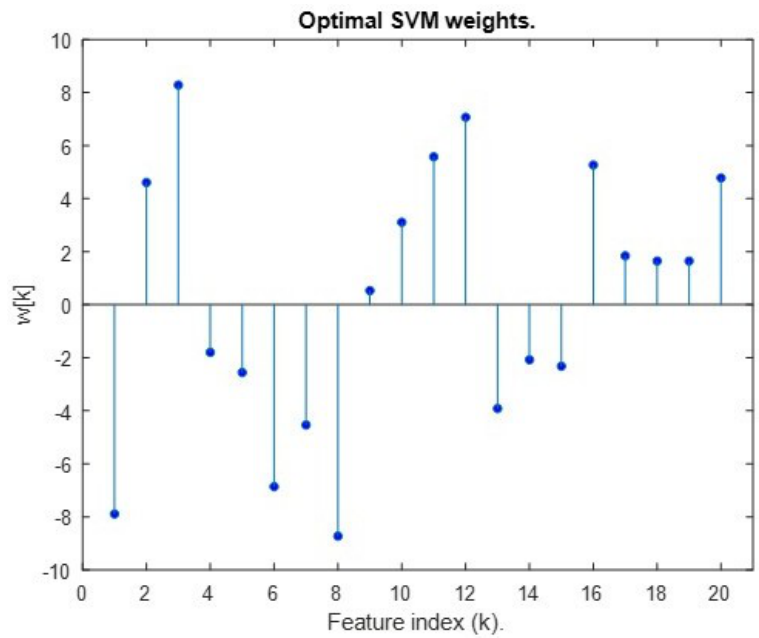
Figure 14. Optimal feature weights chosen by the SVM training optimizer.